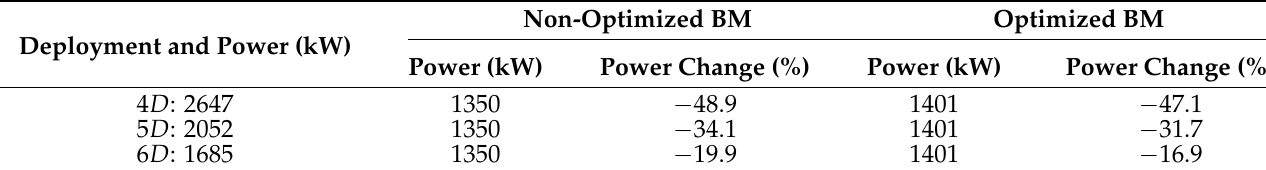
Table 8. Wind plant power increments in comparison with 7 D benchmark (BM).